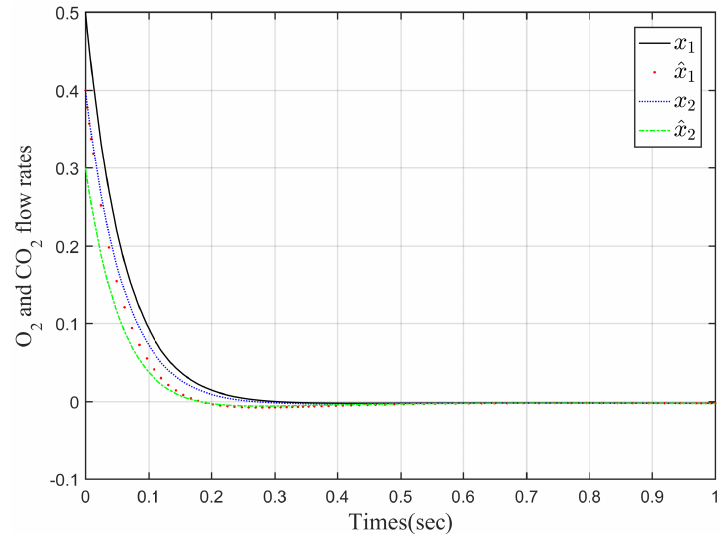
Figure 6. x 1 and x 2 and their